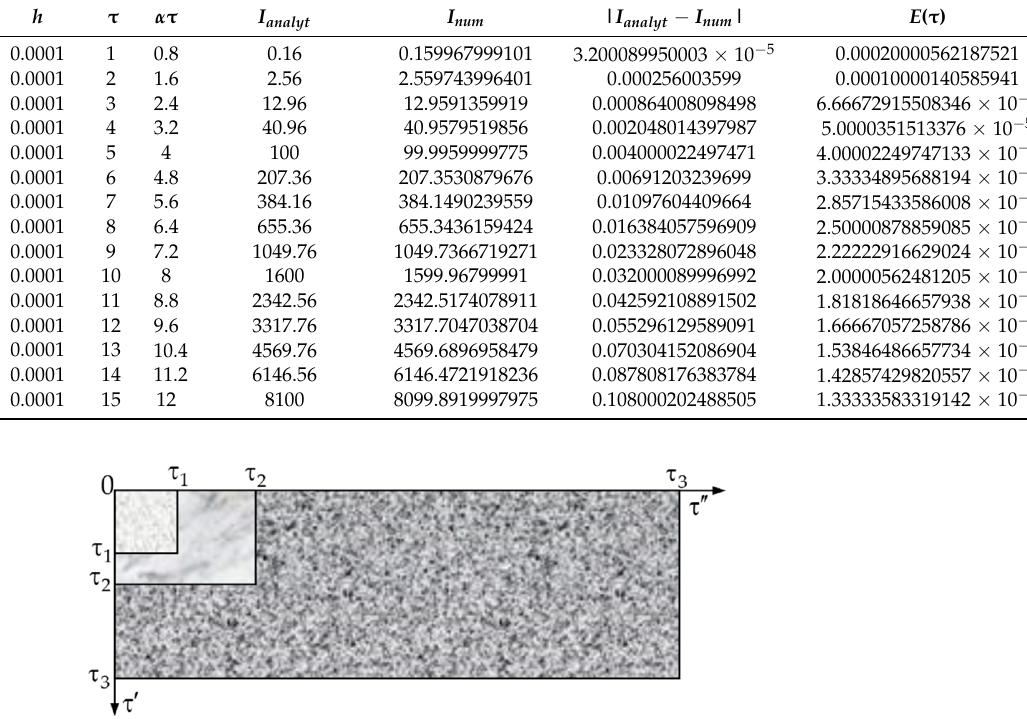
Table 15. Calculation of integral